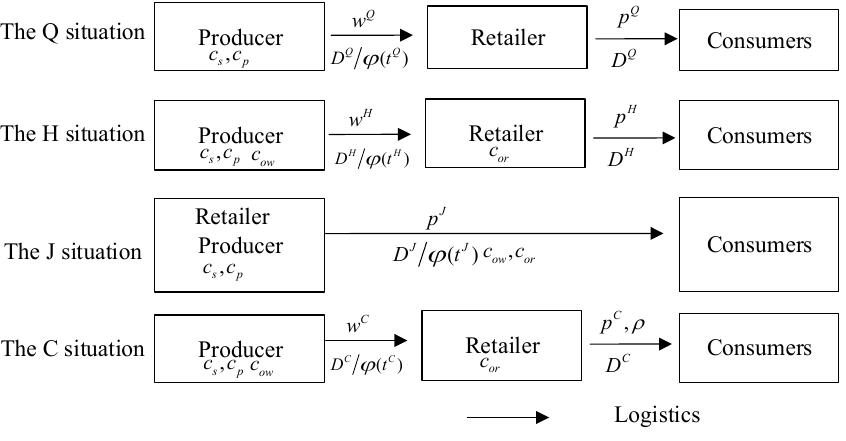
Figure 4. Game process in the proposed four situations.